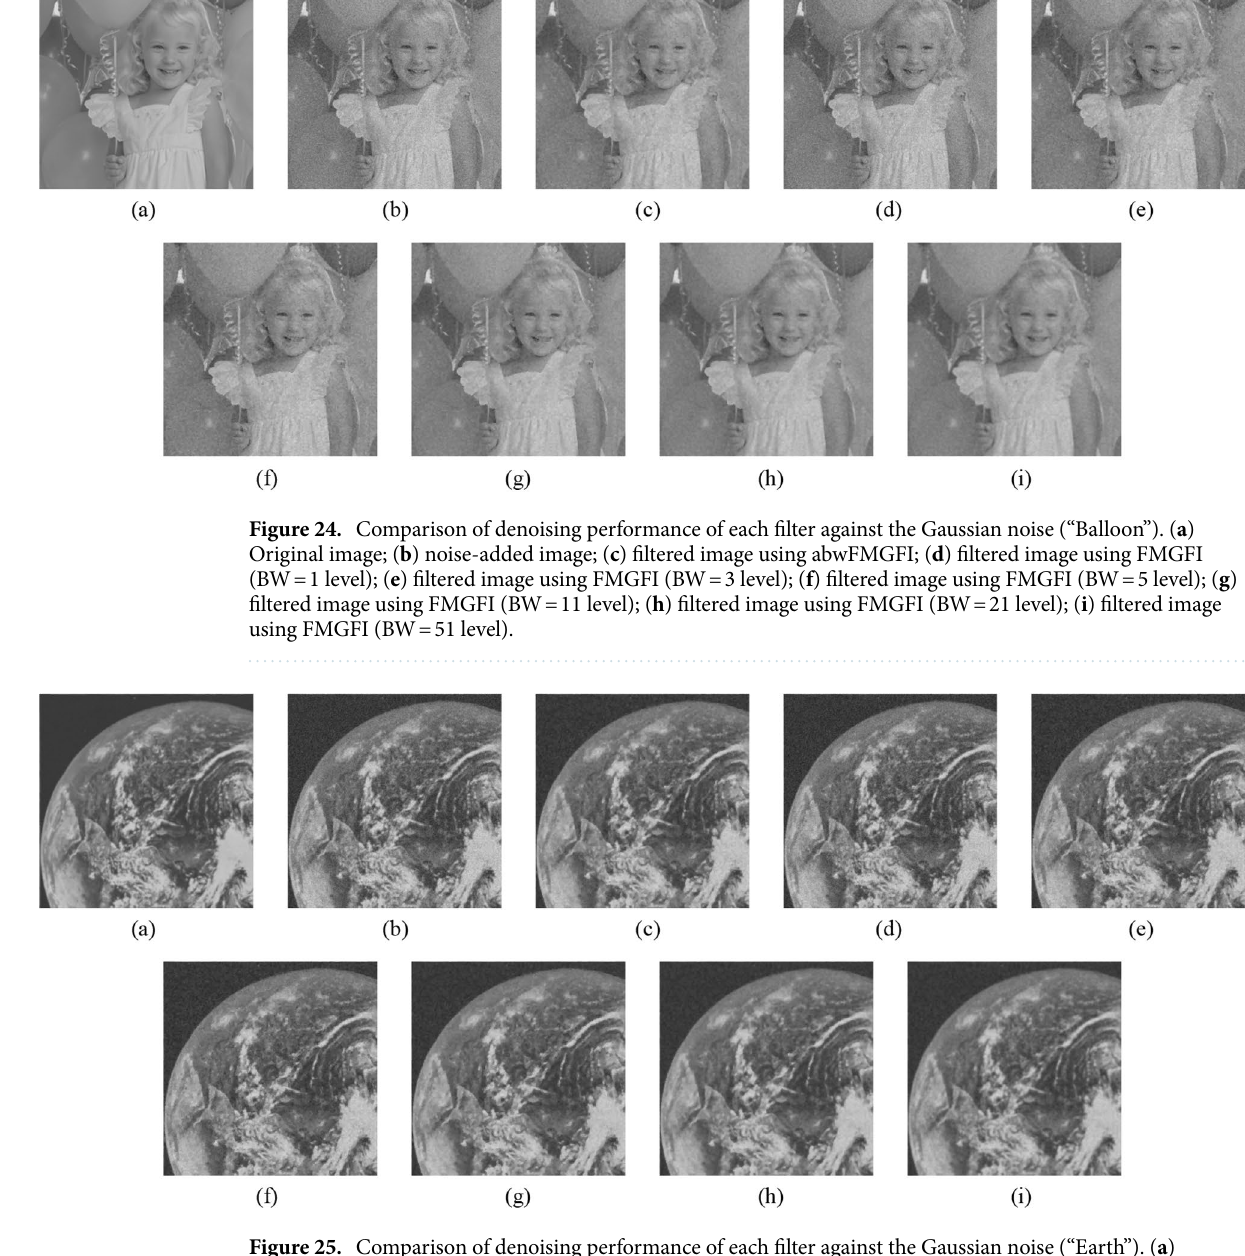
Figure 25. Comparison of denoising performance of each filter against the Gaussian noise (“Earth”). ( a ) Original image; ( b ) noise-added image; ( c ) Filtered image using abwFMGFI; ( d ) filtered image using FMGFI (BW = 1 level); ( e ) filtered image using FMGFI (BW = 3 level); ( f ) filtered image using FMGFI (BW = 5 level); ( g ) filtered image using FMGFI (BW = 11 level); ( h ) filtered image using FMGFI (BW = 21 level); ( i ) filtered image using FMGFI (BW = 51